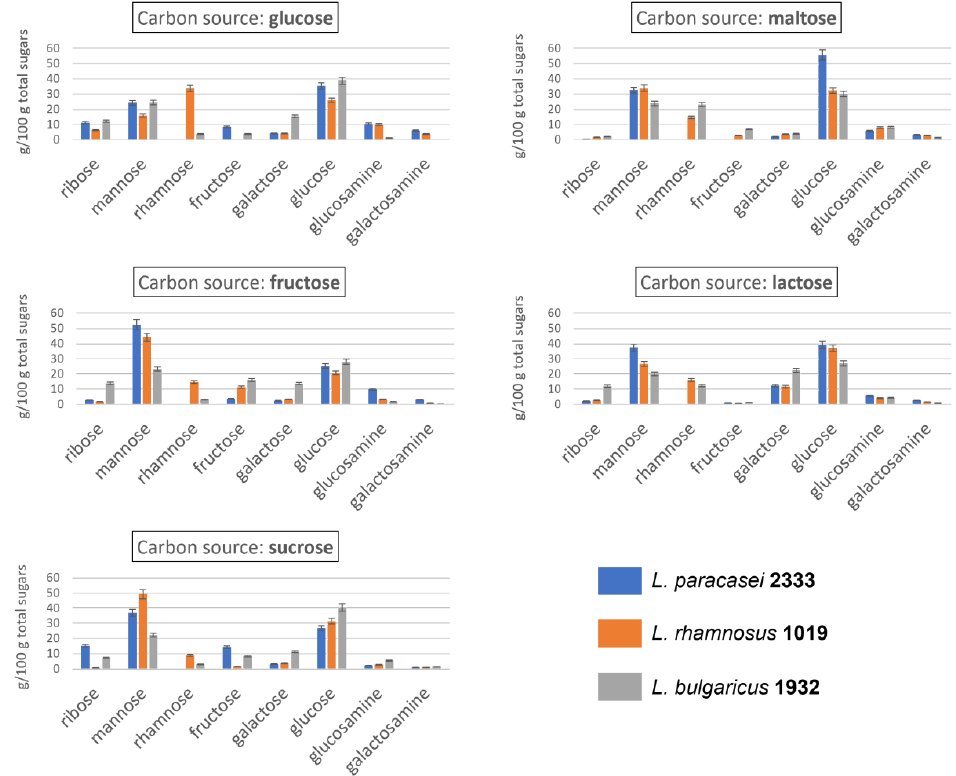
Figure 3. Monosaccharide composition (expressed as relative percentage) of EPS produced by three LAB strains fed five different